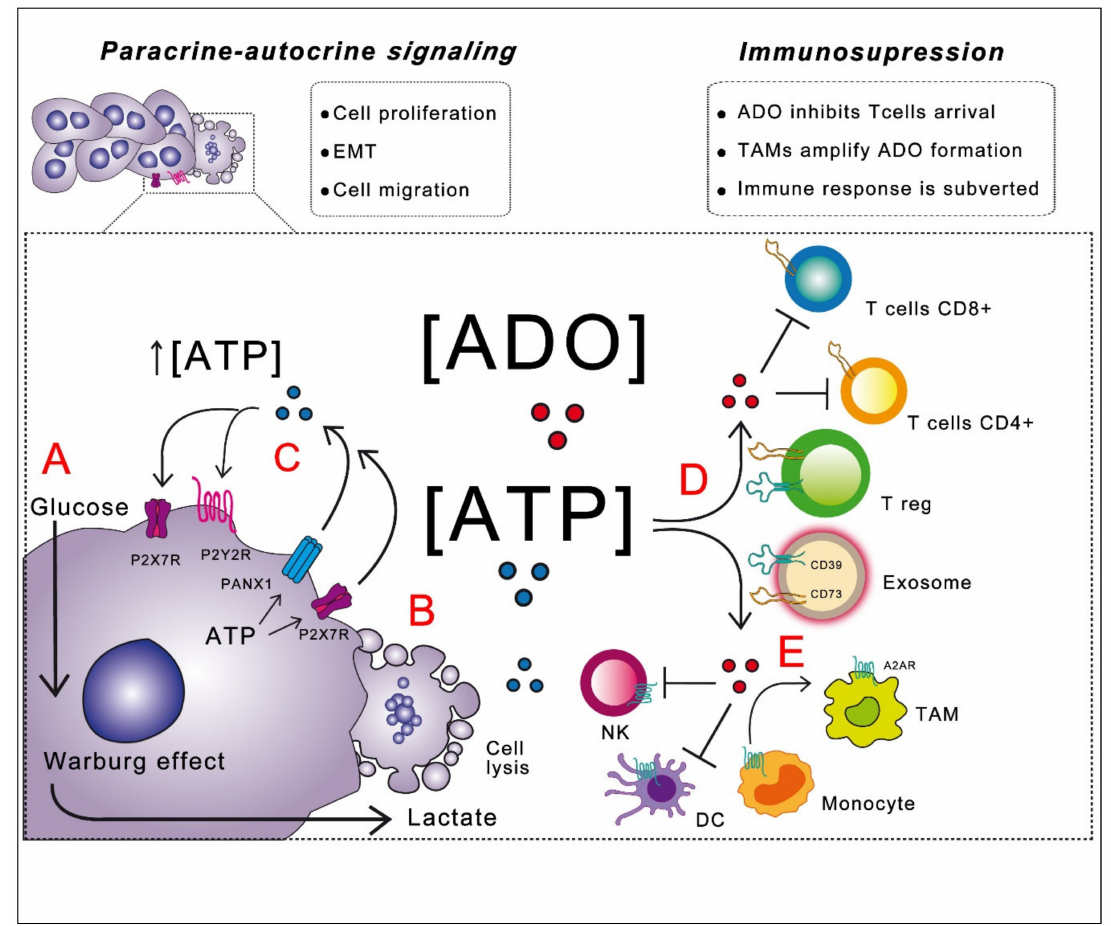
Figure 2. Purinergic signaling and tumor microenvironment (TME). ( A ) Cancer cells synthetize ATP rather from aerobic glycolysis (Warburg e ff ect) which leads to lactate formation and subsequent extracellular acidification. ( B ) ATP is released from tumor cells (pannexin-1 hemichannels and P2X7R have an outstanding role) by general mechanisms or by cellular lysis as result of anticancer therapies and reach hundreds of mM levels, su ffi cient to activate any P2 receptor. ( C ) extracellular ATP in autocrine / paracrine way activate P2 receptors (mainly P2X7R and P2Y2R) to induce proliferation, migration and epithelial to mesenchymal transition (EMT) of cancer cells. ( D ) In TME, ATP is hydrolyzed to ADO by subsequent action of ectonucleotidases CD39 and CD73, which are expressed in the own tumor cells, exosomes and immune cells (i.e., CD4 + , CD25 + , Foxp3 + Treg); contributing to the significant increase of ADO, which in turn inhibits antitumor response of innate immune cells and T e ff ector cells (CD4 + and CD8 + ). ( E ) ADO also contributes to monocyte di ff erentiation into associated tumor macrophages 2s), which also amplify ADO